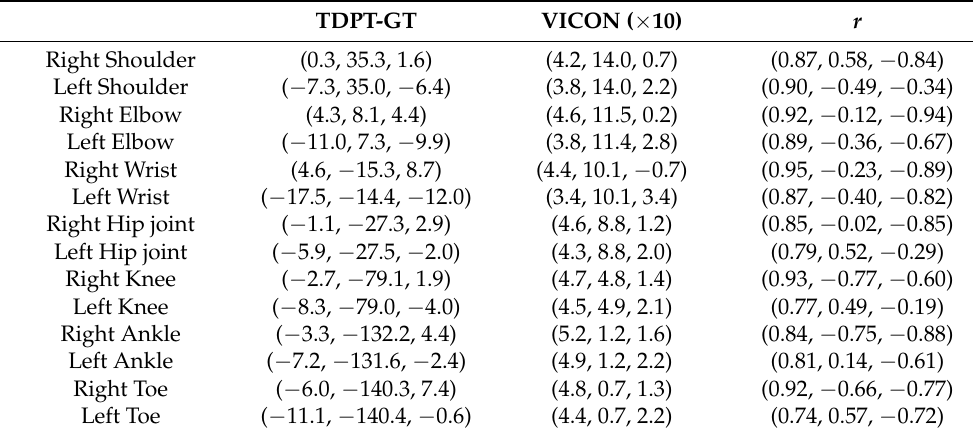
Table 1. Relationship between 3D coordinates with TDPT for Gait Test (TDTP-GT) application and those with VICON Motion